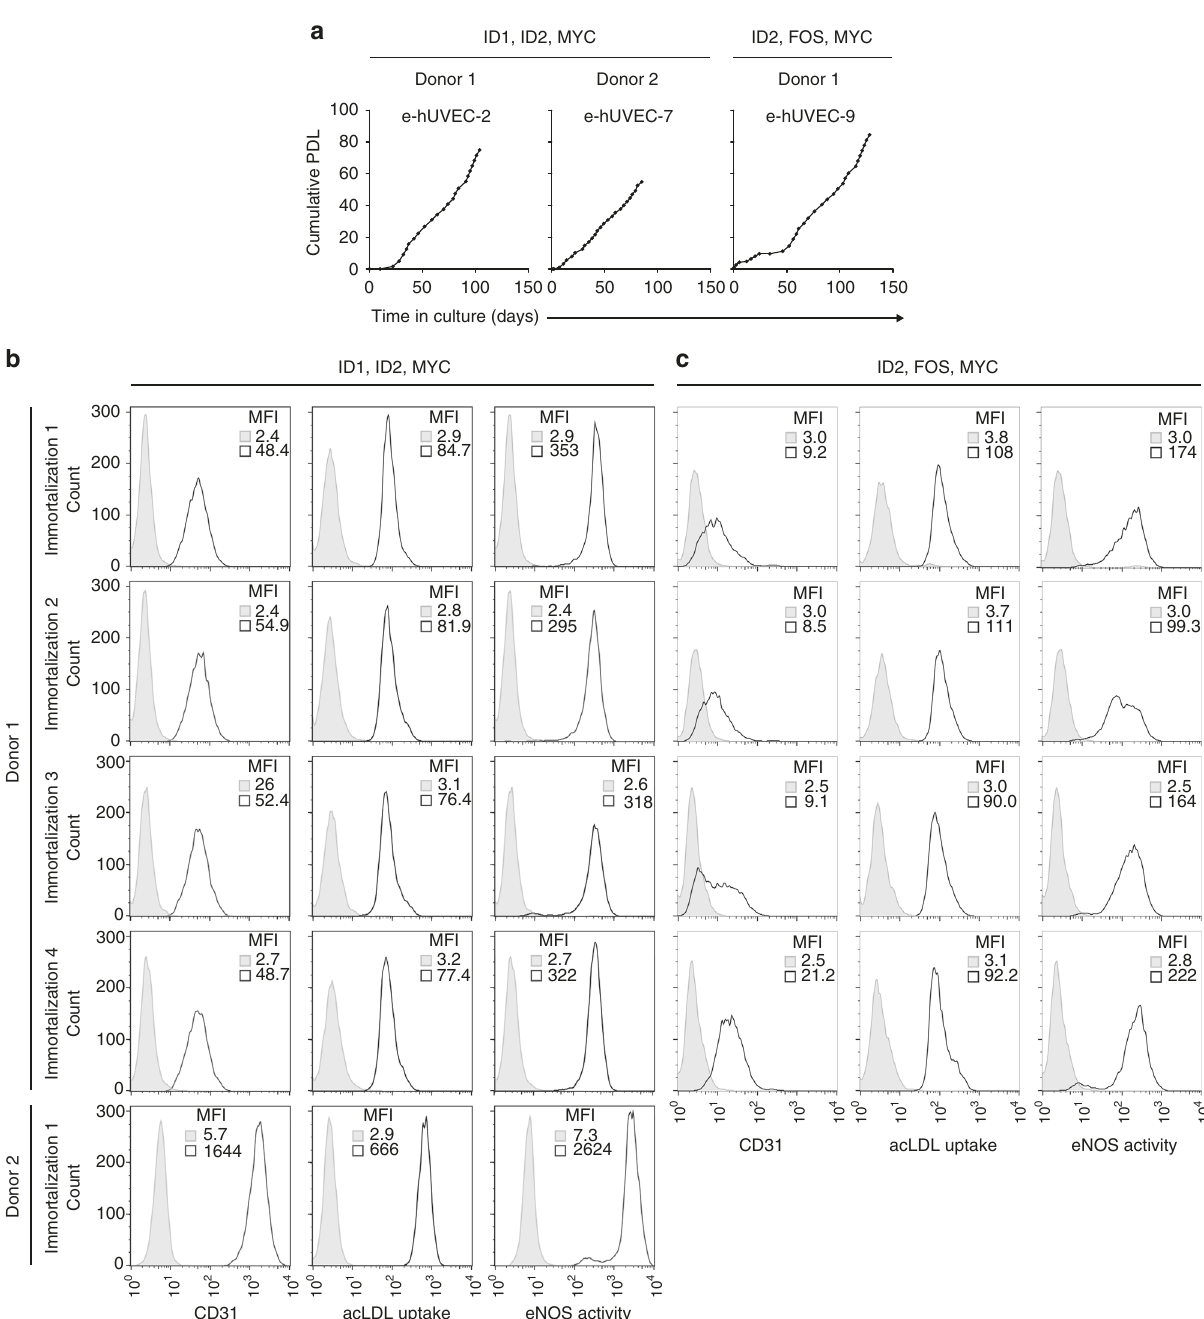
Fig. 4 Cell-type-speci fi c and reproducible cell expansion. a Cumulative population doubling levels of HUVEC lines e-hUVEC-2, e-hUVEC-7, and e-hUVEC- 9. For e-hUVEC-2 and e-hUVEC-7, primary cells were derived from different donors, but generated using the same gene set (ID1, ID2, and MYC). e- hUVEC-9 cells were transduced with ID2, FOS, and MYC. Graphs for e-hUVEC-2 were taken from Fig. 1b. b Four independent endothelial cell lines generated from the same donor upon transduction with MYC, ID1, and ID2 (technical replicates to e-hUVEC-2), and one cell line generated using the same gene set but derived from a different donor (biological replicate to e-hUVEC-2), were analyzed after 80 cumulative population doublings for acLDL uptake, CD31 expression, and eNOS activity. c Four independent endothelial cell lines generated from the same donor upon transduction with ID2, FOS, and MYC (technical replicates to e-hUVEC-9) were analyzed after 80 cumulative population doublings for acLDL uptake, CD31 expression, and eNOS activity. Unstained or isotype control is shown in gray, antibody stained samples are depicted in